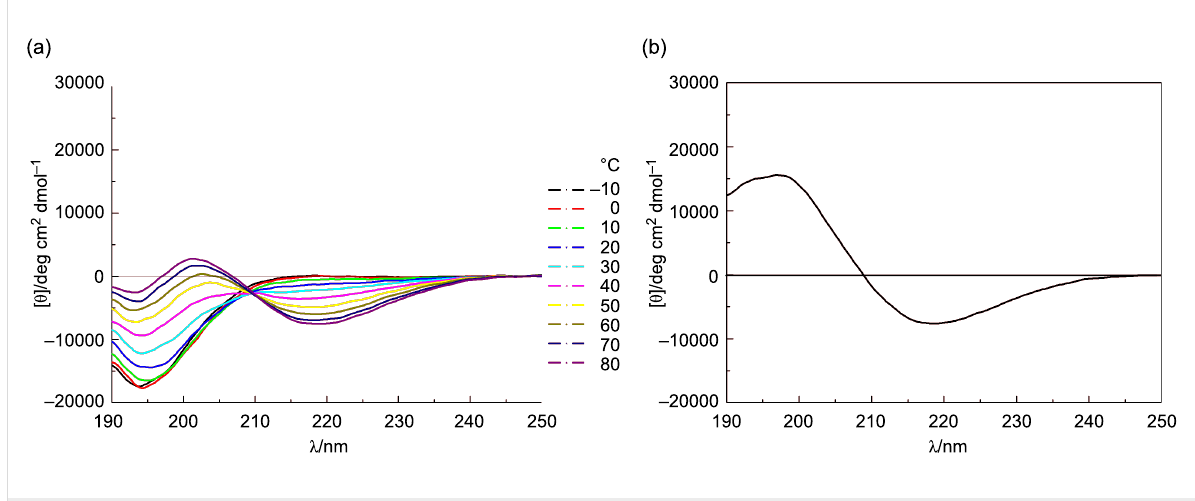
Figure 3: (a) Temperature-dependent CD spectra of the aglycon comprising allo -L-Thr 6 from − 10 to 80 °C in water, revealing an isodichroic point at 209 nm; and (b) the difference spectra between +80 and − 10 °C indicating the contribution of a β -like structure.